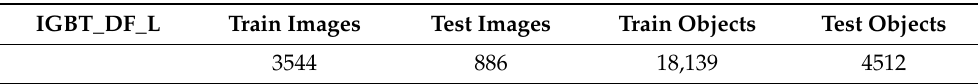
Table 5. Object distribution of IGBT_DF_L dataset (More experimental results can be found in Table A1) for training.